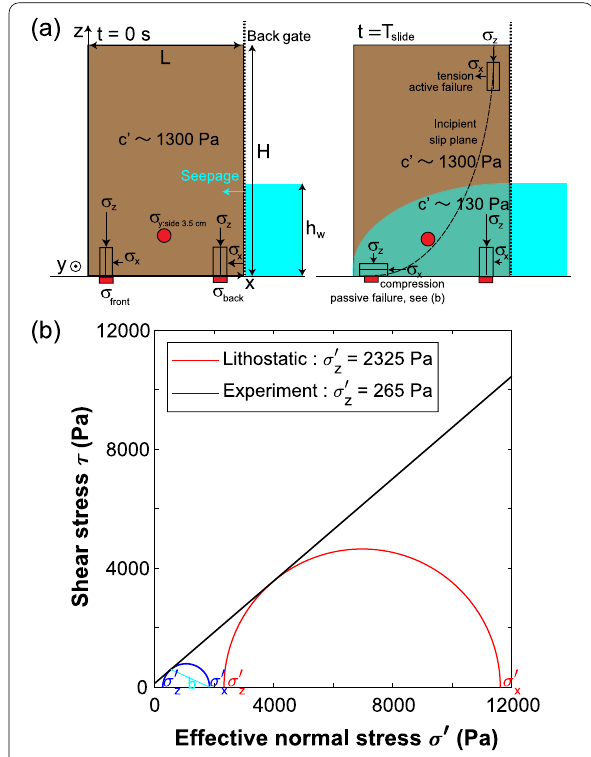
Fig. 12 a A schematic diagram to scale showing the inferred stress changes with seepage. The long axis of a rectangle indicates the major principal stress σ , defined positive when the arrow is directed inward. The figure models the situation of run 14 ( H = 20.0 cm, L = 13.5 cm, h w = 8 cm shown in Fig. 6). A red square (circle) indicates the pressure sensor attached to the base (side wall) and measures the σ z ( σ y ). Left: at the beginning of seepage ( t = 0 s). Right: at t = T slide . Near the cliff head, σ z is the inferred major principal stress, such that active failure (horizontal tension, σ x < 0 ) occurs and a tension crack forms. At the cliff toe, the σ x is the inferred major principal stress, such that passive failure (horizontal compression, σ > 0 ) occurs. The failure angle is steeper at the head (see text). b x Effective Mohr’s circle representation of a passive failure at the cliff toe shown in a right. A black line is the Mohr–Coulomb criterion for saturated ( S = 1 ) sand (see Additional file 4: Table S1 for µ ′ , c ′ ). b ≃ 25 ◦ is the failure angle measured from the horizontal for the experimental